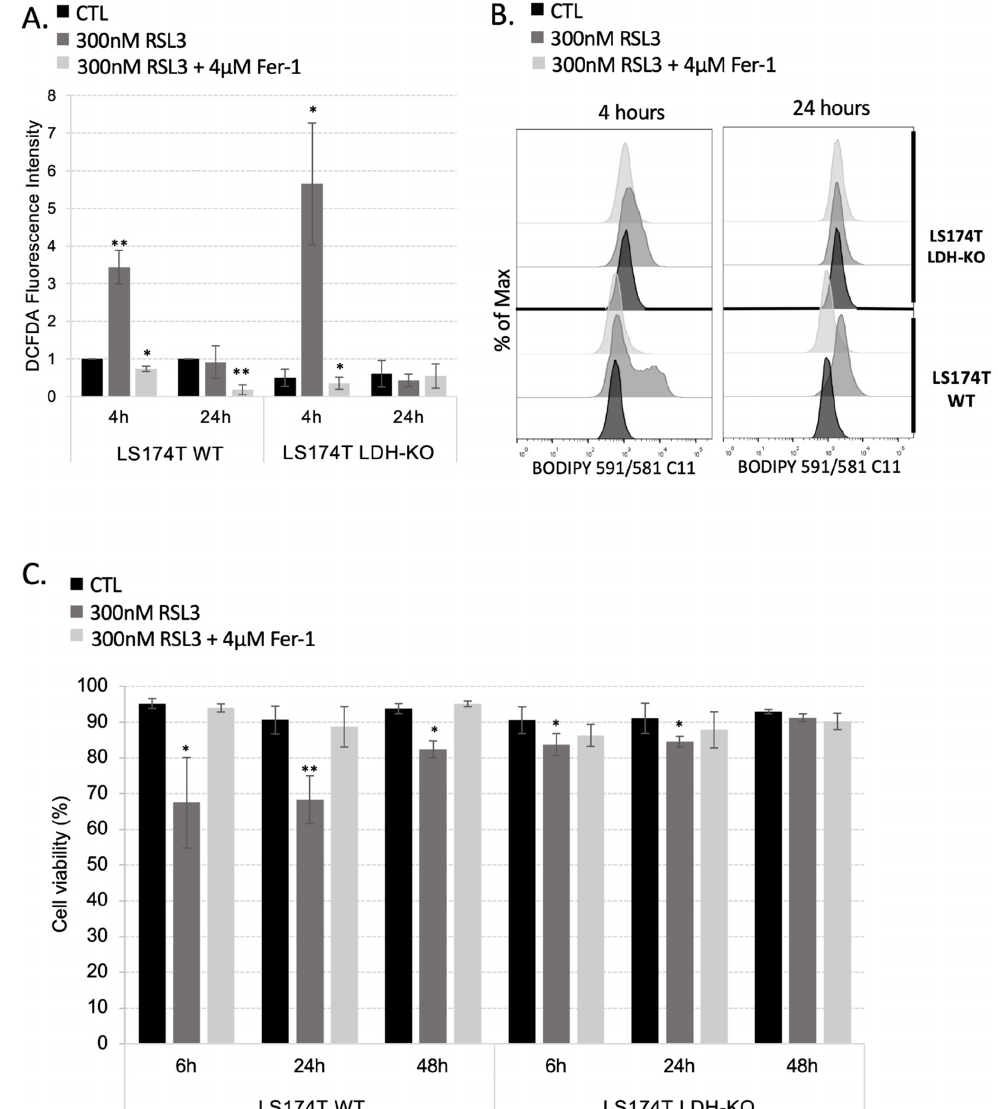
Figure 3. Metabolism rewiring to OXPHOS renders LS174T cells more resistant toward RSL3-induced ferroptosis. ( A ) Intracellular ROS level was measured by DCFDA staining (see Section 2) in LS174T WT and LDH-KO 4 h and 24 h after seeding in media supplemented or not with 300 nM RSL3 and 4 µ M Fer-1. Intracellular ROS levels are presented as fold of change (mean ± SEM, n = 3). * p < 0.05, ** p < 0.01, comparison with corresponding cell line in control conditions. ( B ) Lipid hydroperoxide content was measured in LS174T WT and LDH-KO cells 4 h and 24 h upon seeding in media supplemented or not with 300 nM RSL3 and 4 µ M Fer-1. Presented histograms are representative of three independent experiments. ( C ) Cell viability was measured in LS174T WT and LDH-KO cells using PI staining method (see Section 2). Cells were seeded in media with or without 300 nM RSL3, supplemented or not with 4 µ M Fer-1. Cell viability was analyzed after 6 h, 24 h and 48 h. The results are presented as mean ± SEM, n = 3. * p < 0.05, ** p < 0.01, comparison with corresponding cell line in control